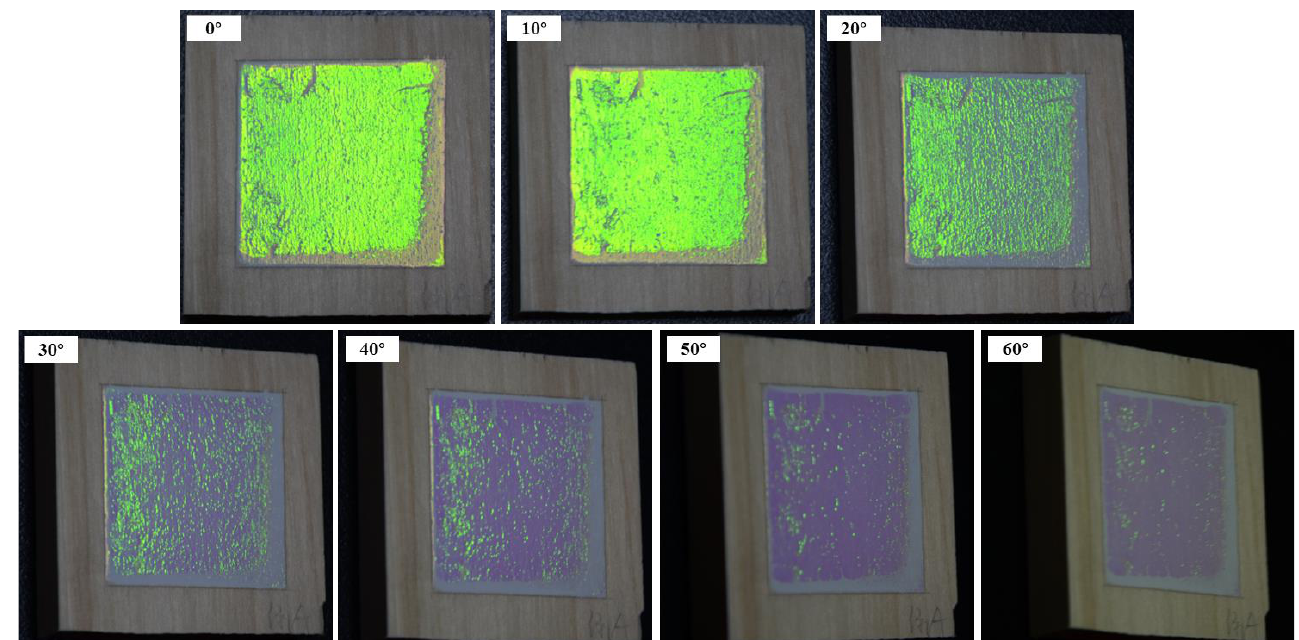
Figure 19. Angle dependence of structural color of photonic crystal constructed by P(St-AA) colloidal microspheres on the wood surface.